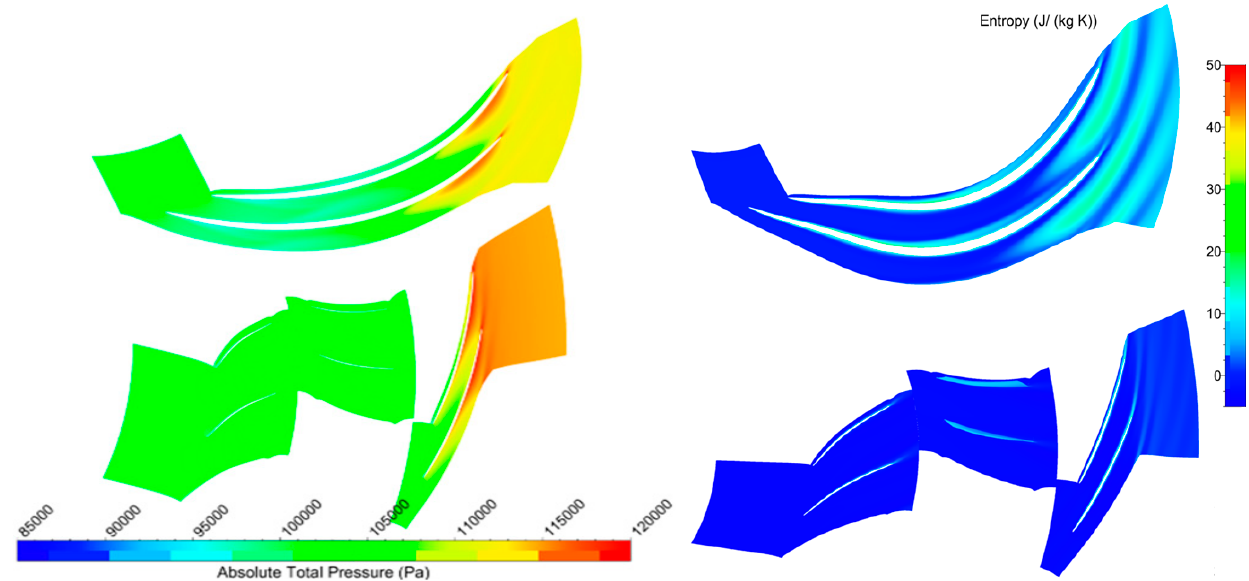
Figure 25. Blade passage view of total pressure at 95% span for both configurations and entropy contours at 50% span.